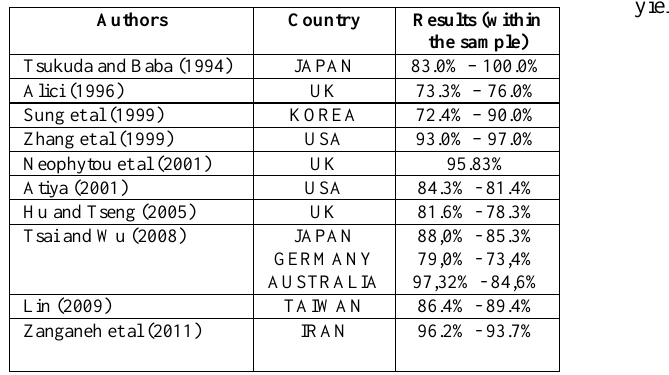
Fig. 1. NN Accuracy in experiment